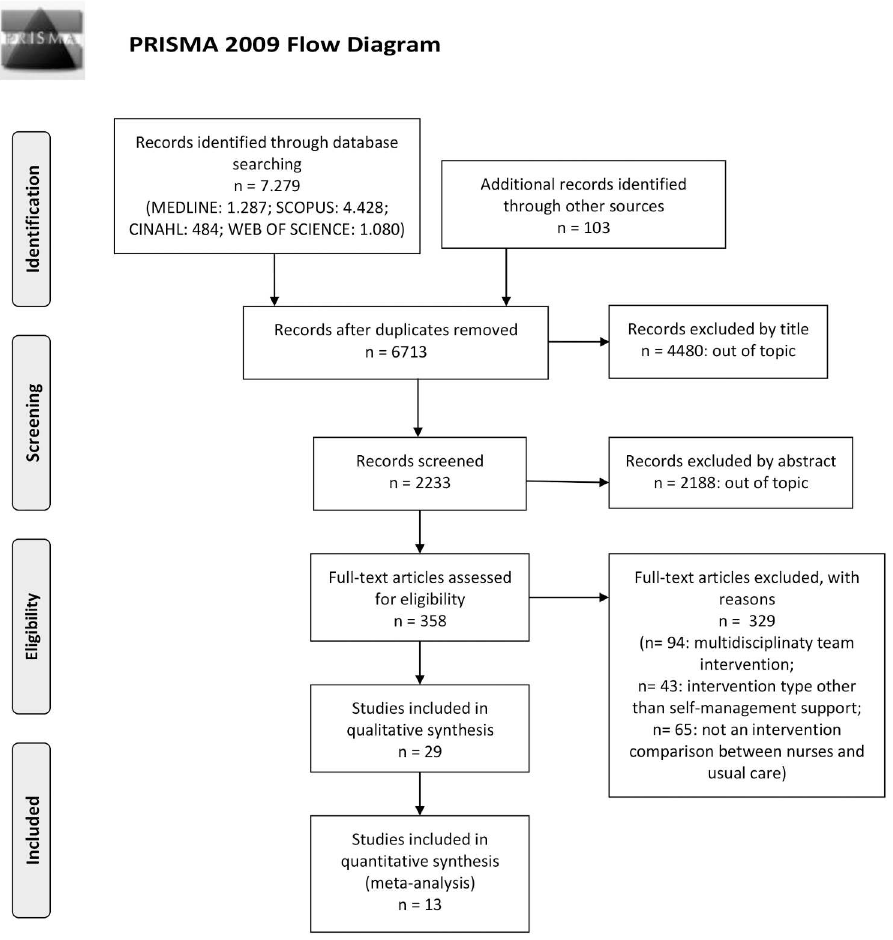
Fig 1. Flow diagram of the study selection process. From : Moher D, LiberatiA, Tetzlaff J, Altman DG, The PRISMA Group (2009). Preferred ReportingItems for Systematic Reviewsand Meta-Analyses: The PRISMA Statement. PLoS Med 6(7): e1000097.doi: